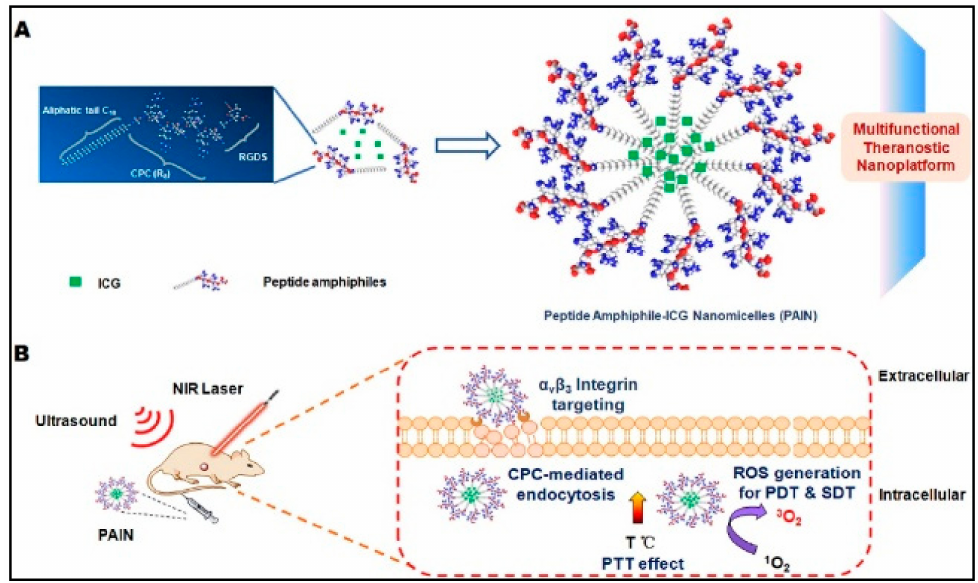
Figure 14. ( A ) Self-assembled of the prepared peptide-based ICG nanomicelles and ( B ) the NIR and ultrasound irradiation effects on the tumor mice. Reprinted with permission from [210]. Copyright © 2020,